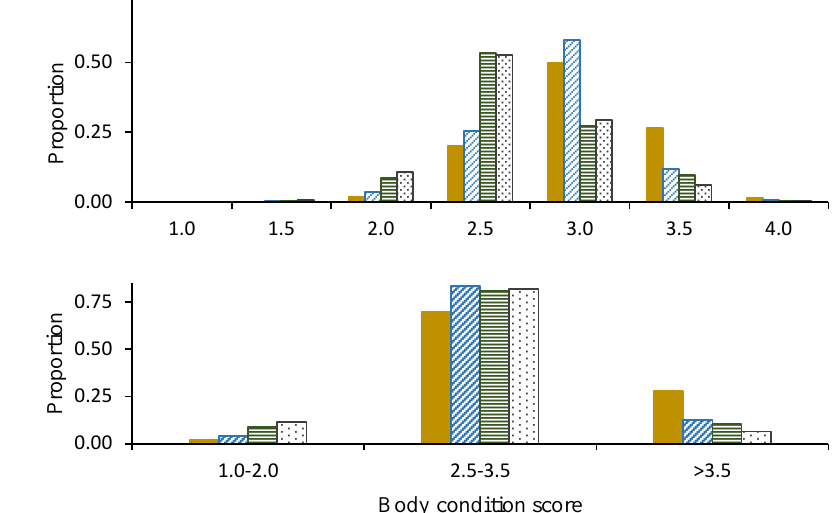
Figure 1. Distribution of ewe body condition scores by stage of the annual cycle from 18,354 individual records of 5761 ewes during their fourth year (43–54 months) of age. Bar colors (grey, yellow, blue and green) indicate BCS proportions at pre-breeding, pregnancy diagnosis, pre-lambing and weaning respectively. In ( A ), a BCS of 1–4-point scale was used and in ( B ), 1–3 scale (BCS 1.0–2.0: 1, 2.5–3.5: 2 and >3.5: